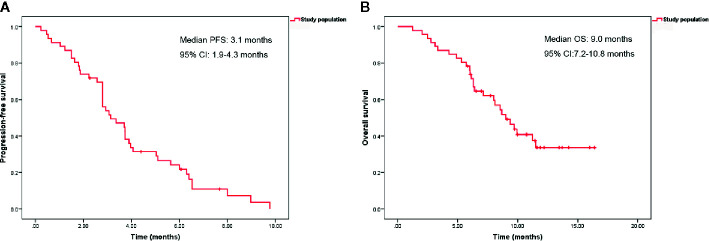
Kaplan-Meier curves of progression-free survival (A) and overall survival (B) in 46 patients.